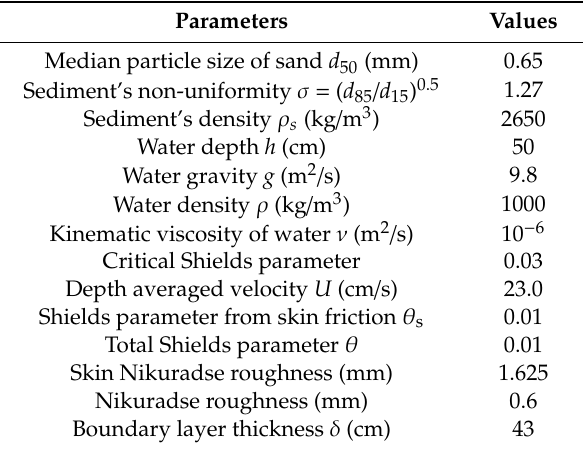
Table 1. Test parameters.